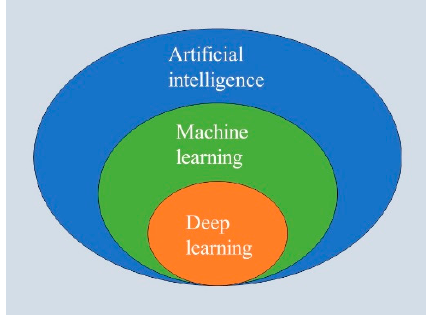
Figure 1. Schematic diagram of artificial intelligence, machine learning, and deep learning.